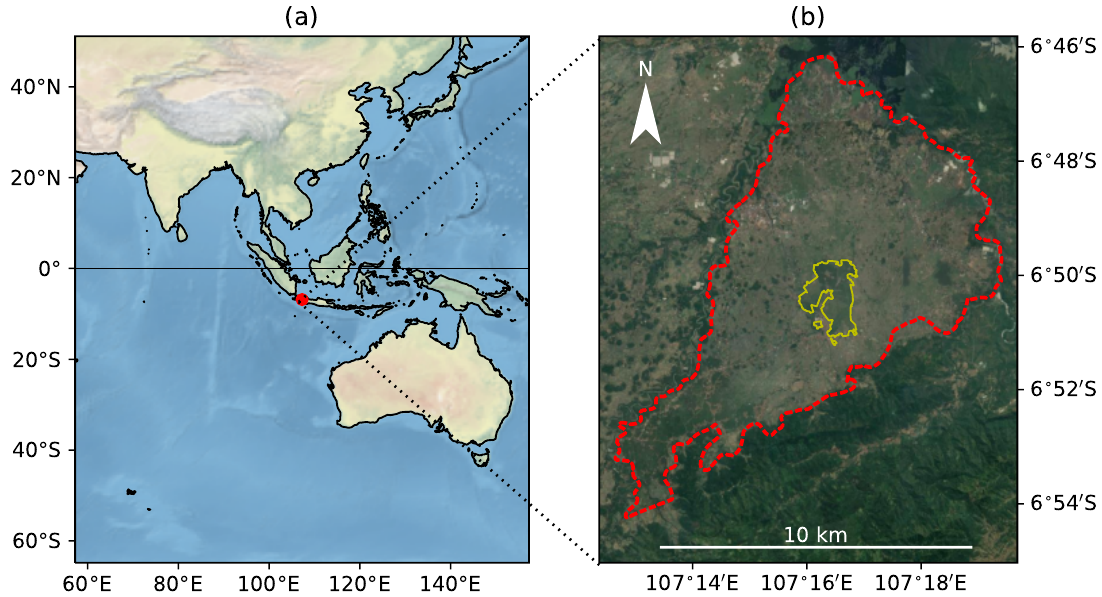
Figure 1. Maps showing the study area as well as the area around it. ( a ) Around Java Island. The Cihea irrigation district is located in the circle. ( b ) Around the Cihea irrigation district. The dashed line indicates the boundary of the Cihea irrigation district and the solid line indicates the boundary of the test